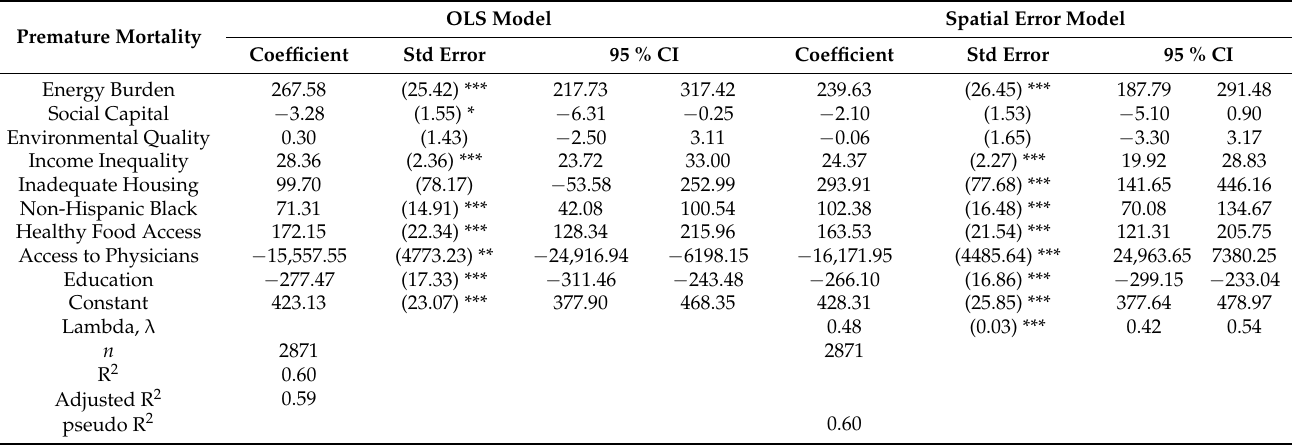
Table 2. The results of spatial error models of factors shaping premature mortality in US counties.